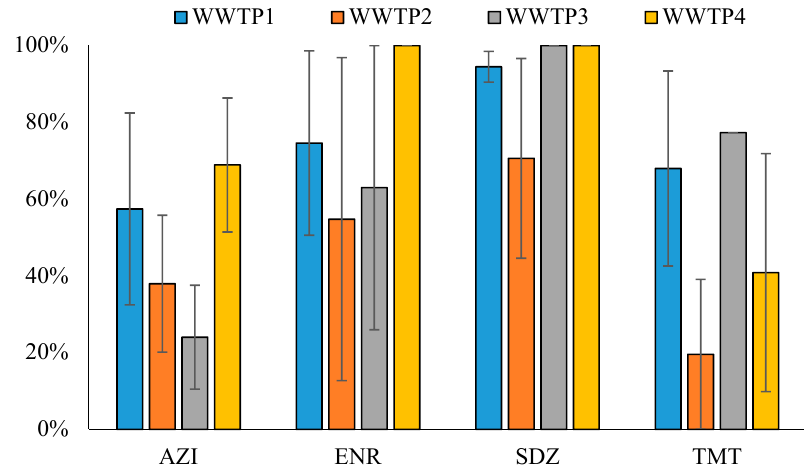
Figure Figure 4. Wastewater treatment plants’ removal efficiency for each antibiotic in 2018–2019 (AZI = azithromycin, ENR = enrofloxacin, SDZ = sulfadiazine, TMT = trimethoprim).